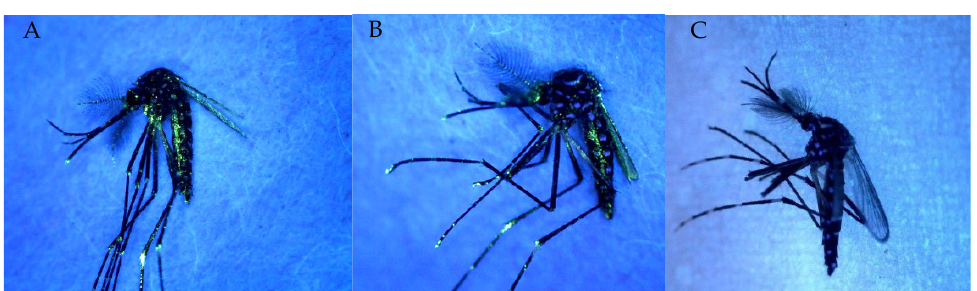
Figure 1. Pictures of marked (500 mg powder) 1 day old ( A ), 20 days old ( B ) and unmarked 3 days